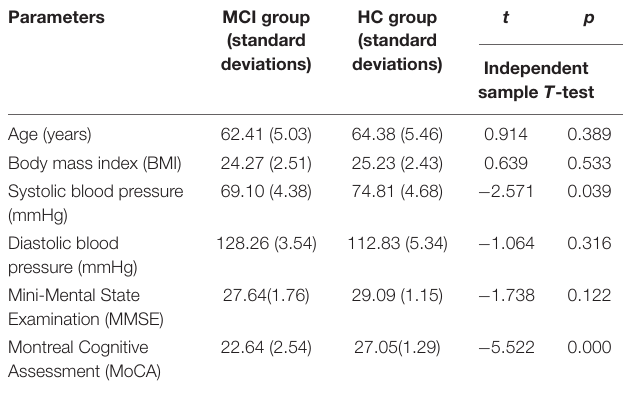
TABLE 1 | Basic information of the